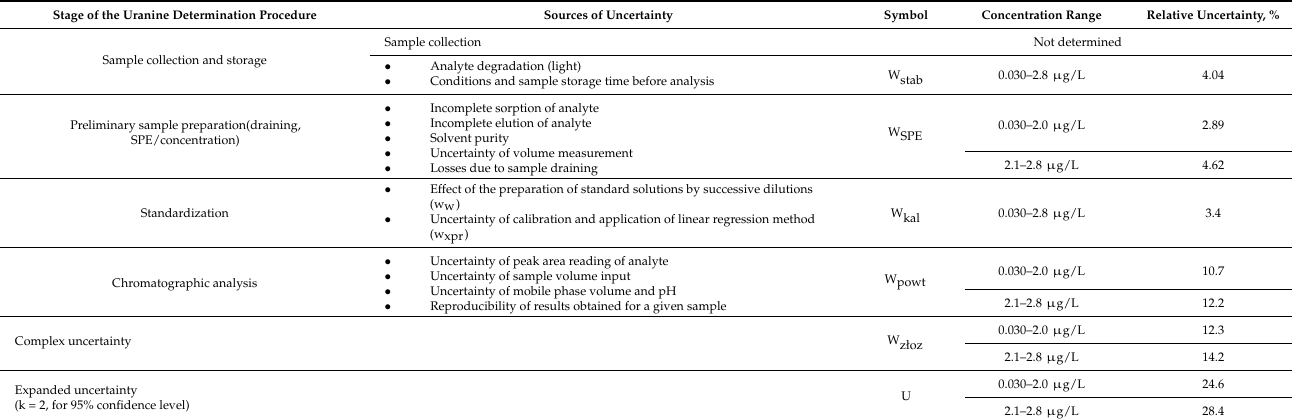
Table 10. Sources and estimated values of uncertainty components characterized for the HPLC/FLD method of uranine determination in formation water